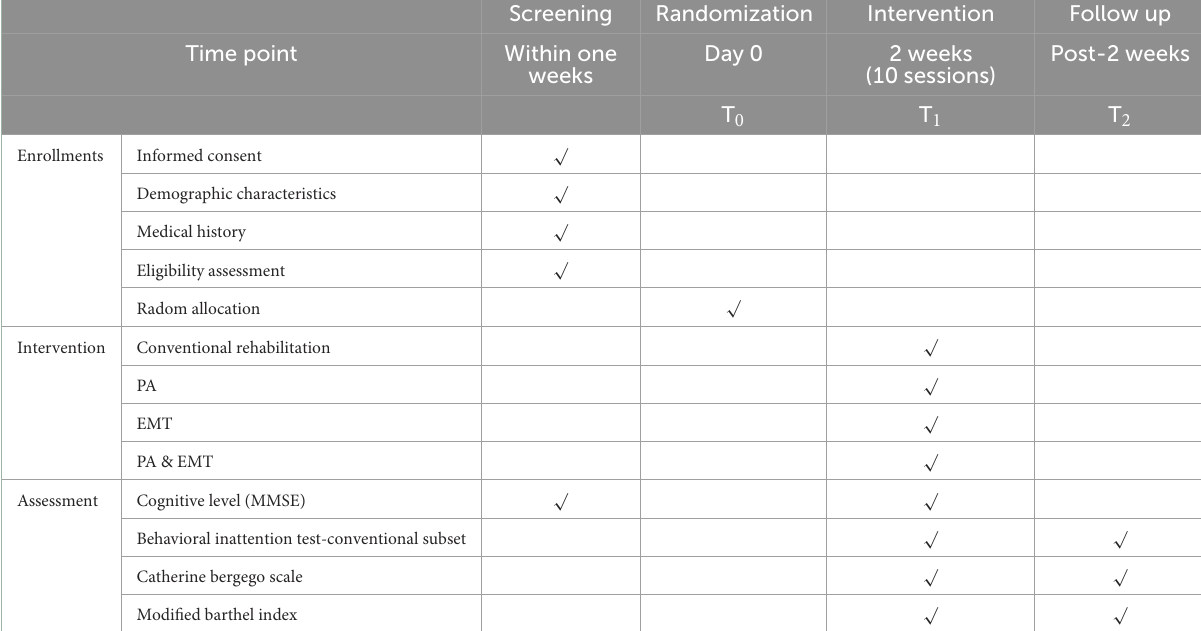
TABLE 1 Schedule of enrollments, interventions, and assessments. Screening Randomization